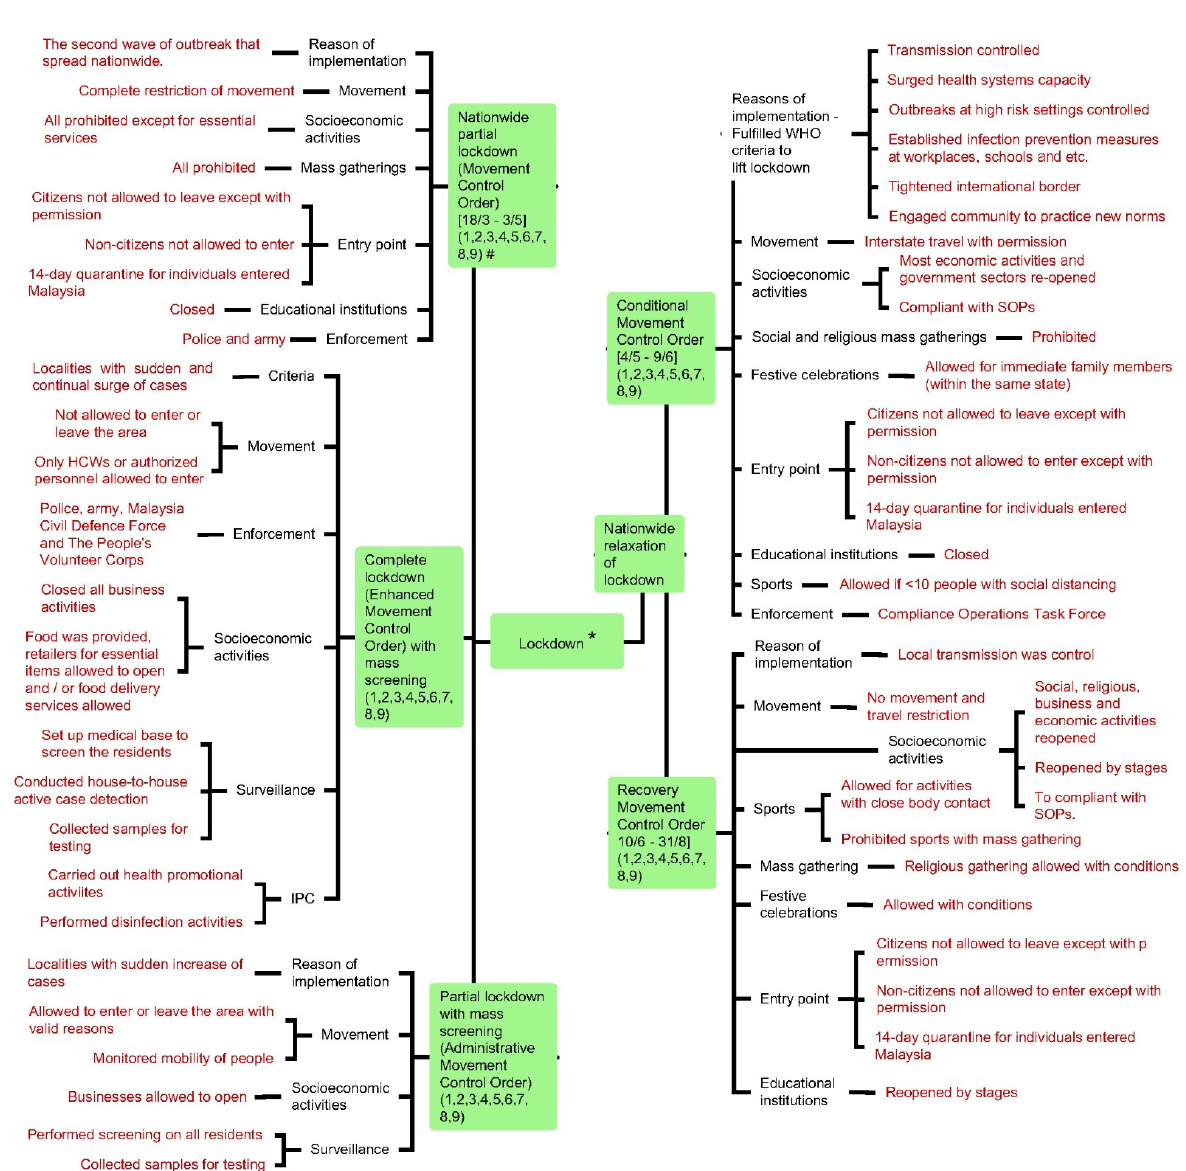
Figure A2. The types and differences of lockdown implemented by Malaysia during the COVID-19 pandemic. # Numbers in parentheses denote WHO Pillars. * Measures implemented: (i) before the first wave (31 December to 24 January) indicated in blue, (ii) during the first wave (25 January–26 February) indicated in orange, and (iii) during the second wave (27 February onwards) indicated in red.